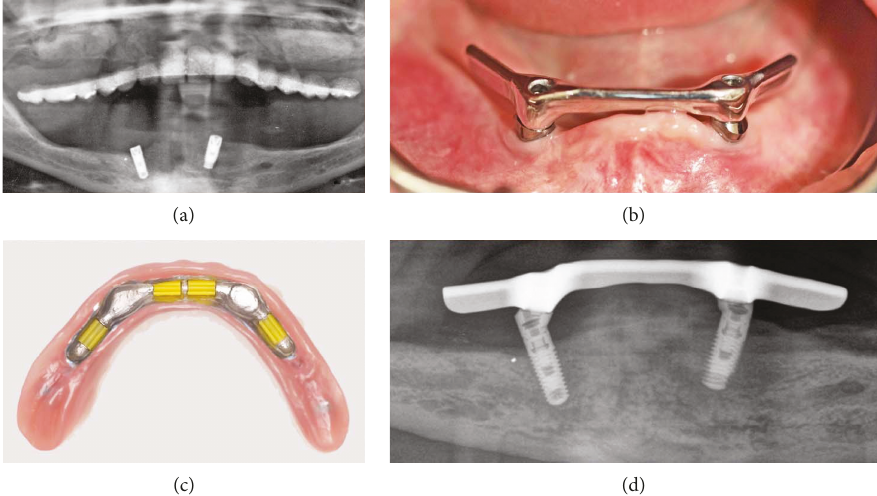
Figure 4: Sinus augmentation and mandibular restoration: (a) OPG after sinus augmentation and implant placement in the mandible; (b) implant-retained bar; (c) clips for retention of the base over the bar; (d) OPG section after loading of the mandibular